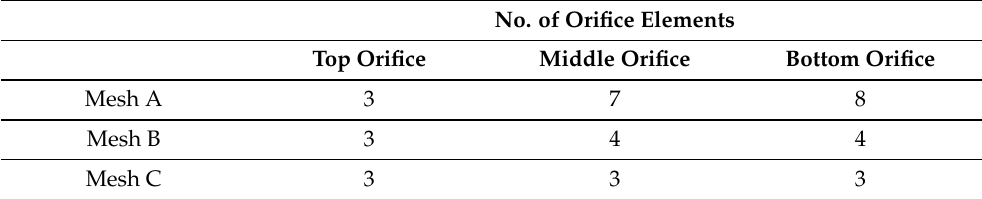
Table 2. Number of one-dimensional orifice elements in each computational mesh. No. of Orifice Elements Top Orifice Middle